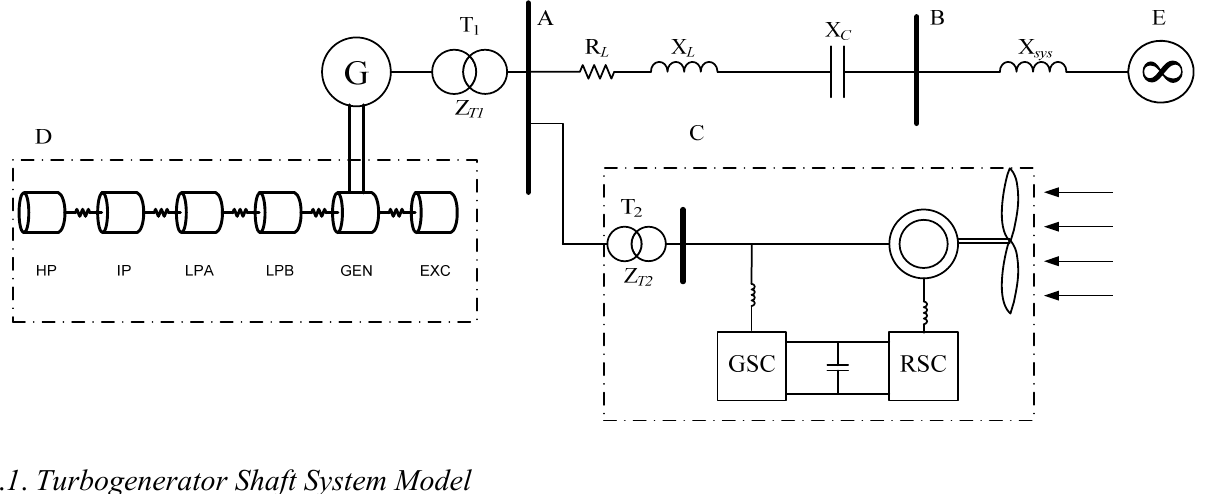
Figure 1. Schematic of a DFIG-based wind farm connected to the IEEE first benchmark